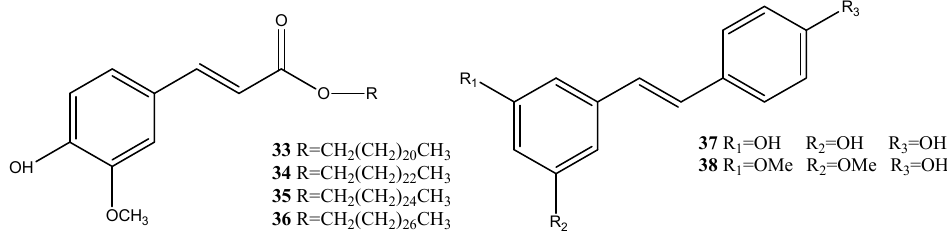
Figure 8. Structures of phenolic